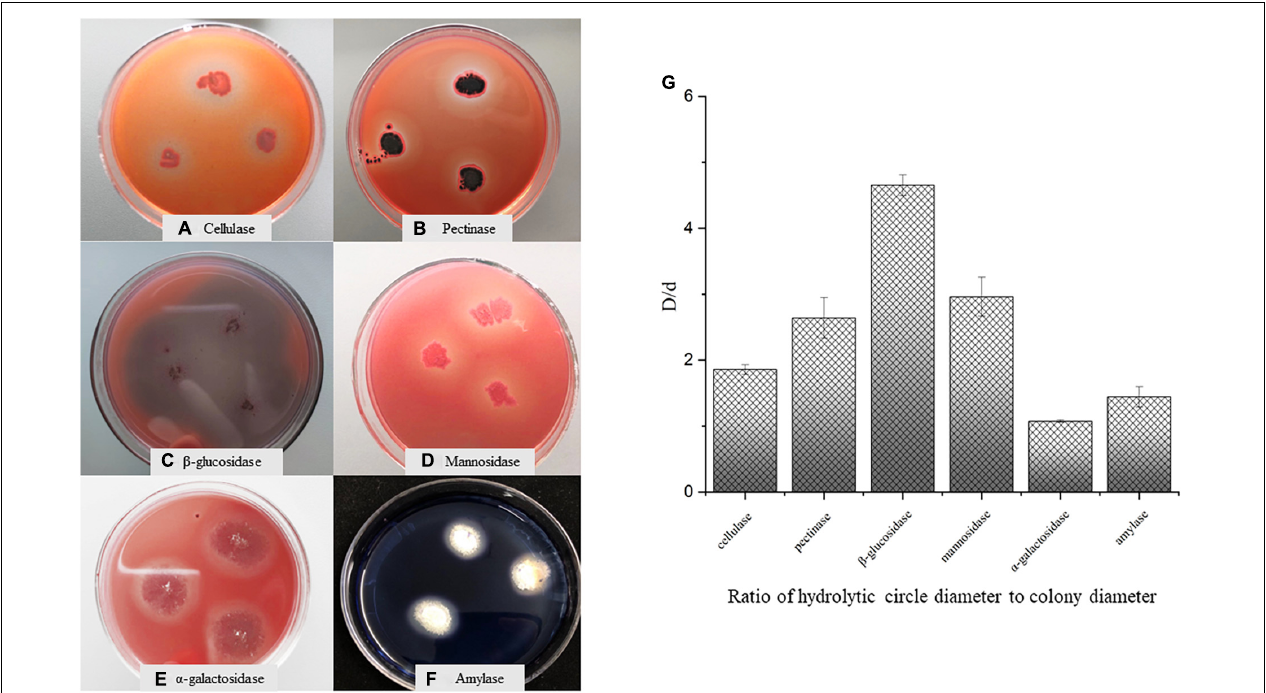
FIGURE 4 | Analysis of glycoside hydrolase secreted by Aspergillus niger M10. (A) Cellulase, (B) pectinase, (C) β -glucosidase, (D) mannosidase, (E) α -galactosidase, (F) amylase, and (G) ratio of hydrolytic diameter to colony diameter.